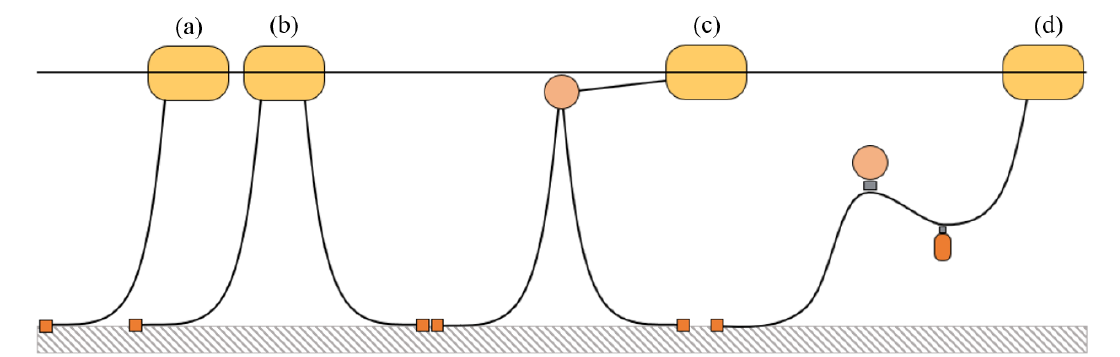
Figure 1. Mooring configurations: ( a ) catenary; ( b ) multi-catenary; ( c ) CALM; ( d )